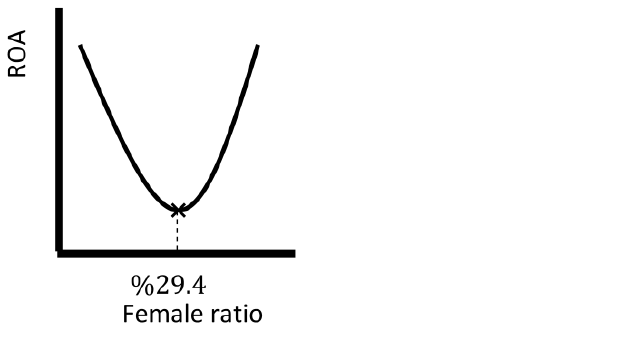
Figure 3. The critical female ratio in the full sample with respect to EPS. Figure 4. The critical female ratio in non-financial firms with respect to ROA.